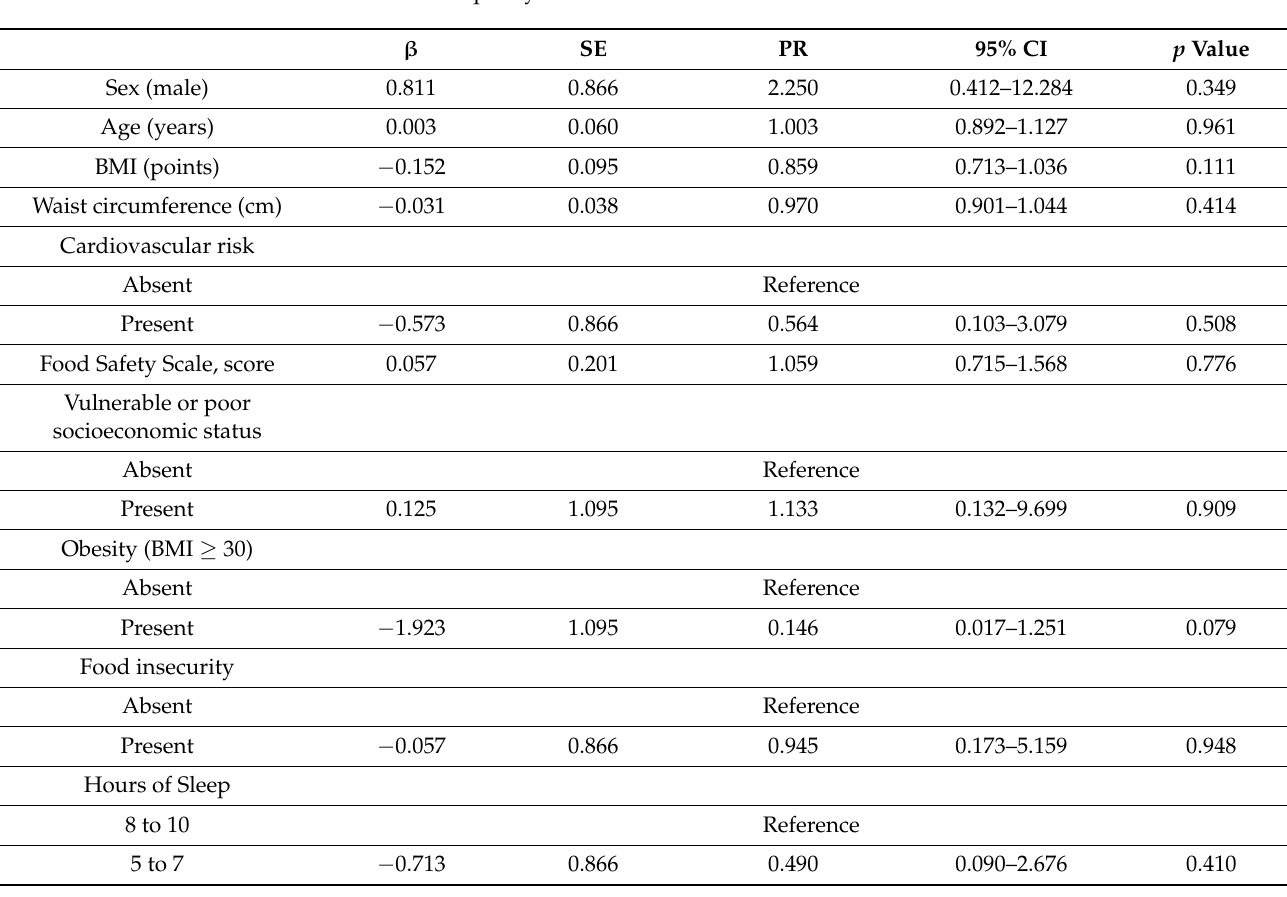
Table 6. Results of Poisson regression to determine the association between demographic and lifestyle variables with quality of